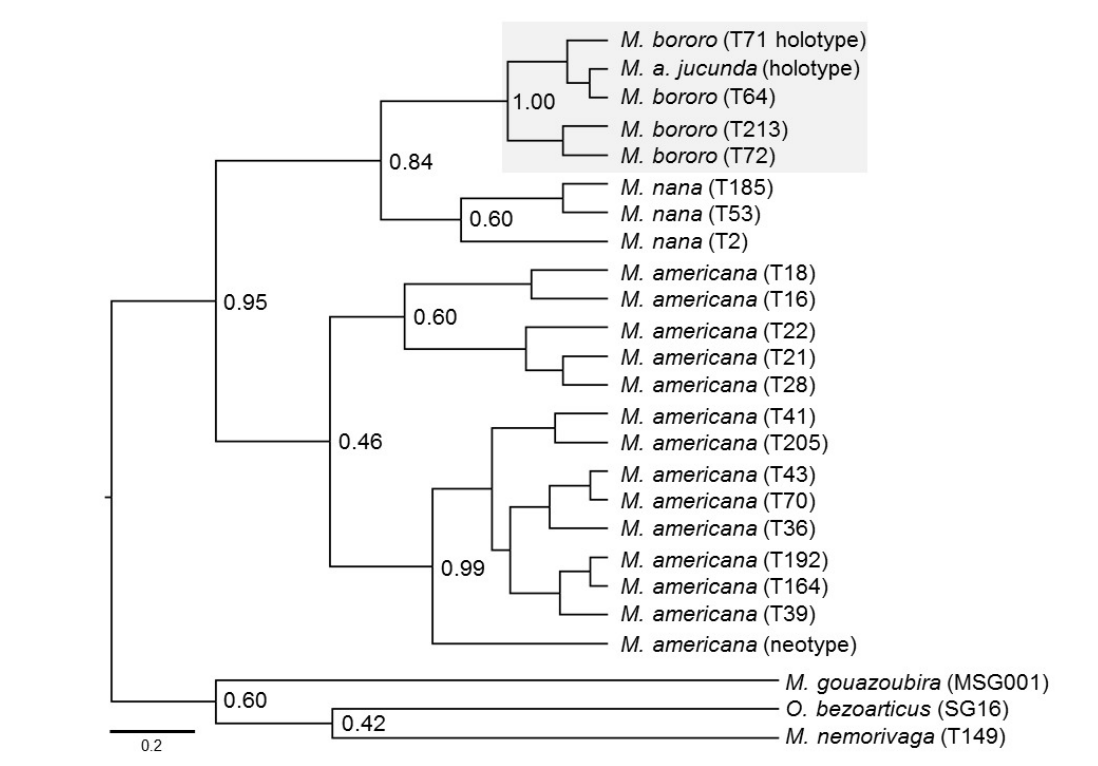
Figure 1 – Phylogenetic tree obtained from a Bayesian inference analysis of the unique haplotypes of the mitochondrial cytochrome b gene, showing the close phylogenetic relationship between Mazama bororo and Mazama americana jucunda . The numbers on the nodes of the tree represent the posterior probability values. The sample identification is shown in